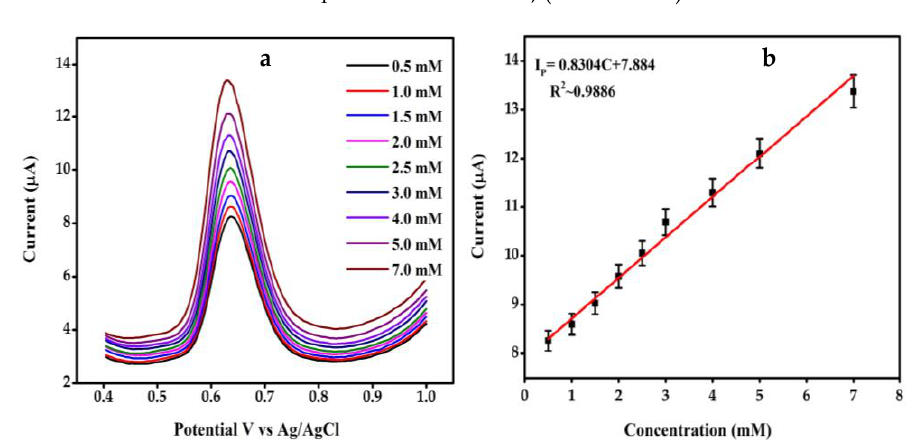
Figure 6. ( a ) DPV plot of SGP2 GCE and ( b ) linear calibration plot.